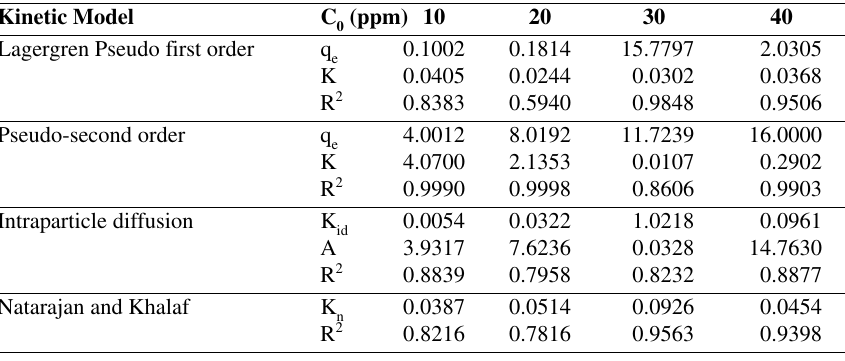
Table 2. Kinetic results for the adsorption process